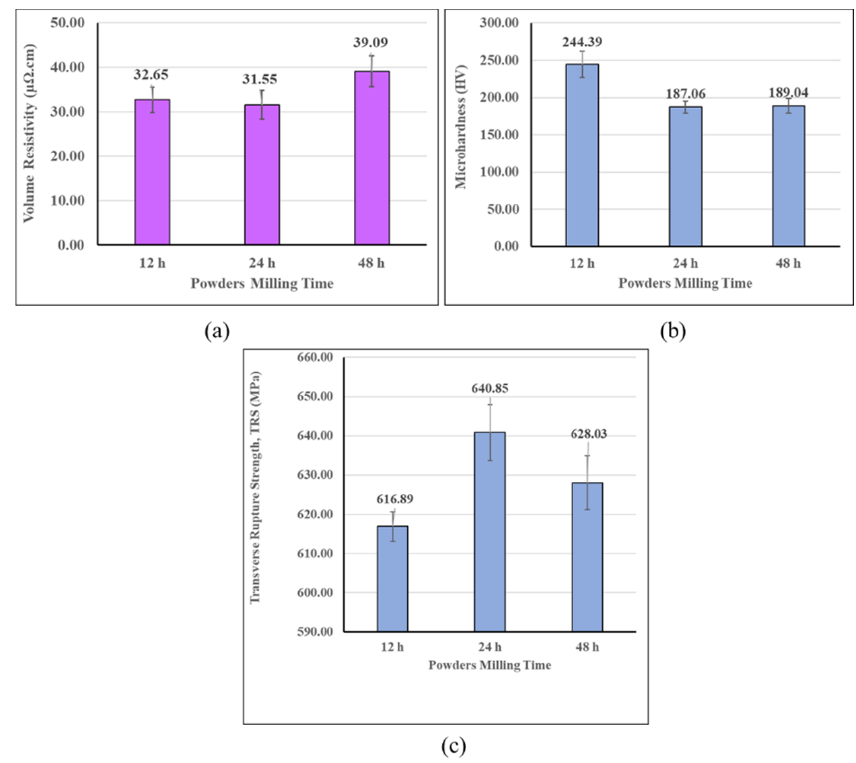
Figure 11. Effect of milling time on: ( a ) electrical resistivity; ( b ) Vickers microhardness and ( c ) transverse rupture strength of 80nFe-19Al-1MWCNT nanocomposite.